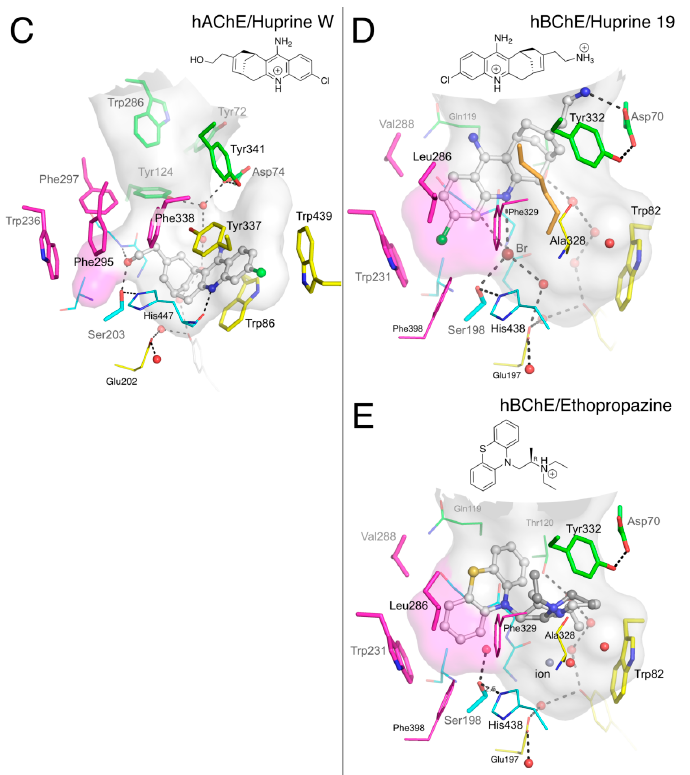
Figure 5. Complexes of propidium with mAChE ( A ; pdb 1n5r) and hBChE ( B ; pdb 6esj); huprine W with hAChE ( C ; pdb 4bdt); huprine 19 with hBChE ( D ; pdb 6eqq); and ethopropazine with hBChE ( E ; pdb 6eqp). The gorge is depicted by its molecular surface (semi-transparent gray and magenta for the acyl-binding pocket). Nitrogen atoms are in blue, oxygen in red, sulfur in yellow, chlorine in green, bromine in brown and other ion in grey. The ligand is represented in ball and stick format with carbon atoms in white. The residues in the vicinity of the ligand are represented in stick or lines. In the A-site, catalytic and oxyanion hole residues are in cyan, choline-binding pocket residues in yellow and acyl-binding pocket residues in magenta. P-site residues are in green. Water molecules are in red spheres. The hydrogen bonds are represented in dashed lines.